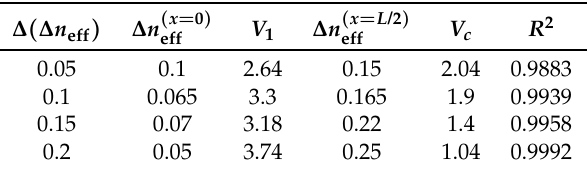
Table 2. Results of the optimization process to obtain parabolic phase profiles with pyramid- shaped